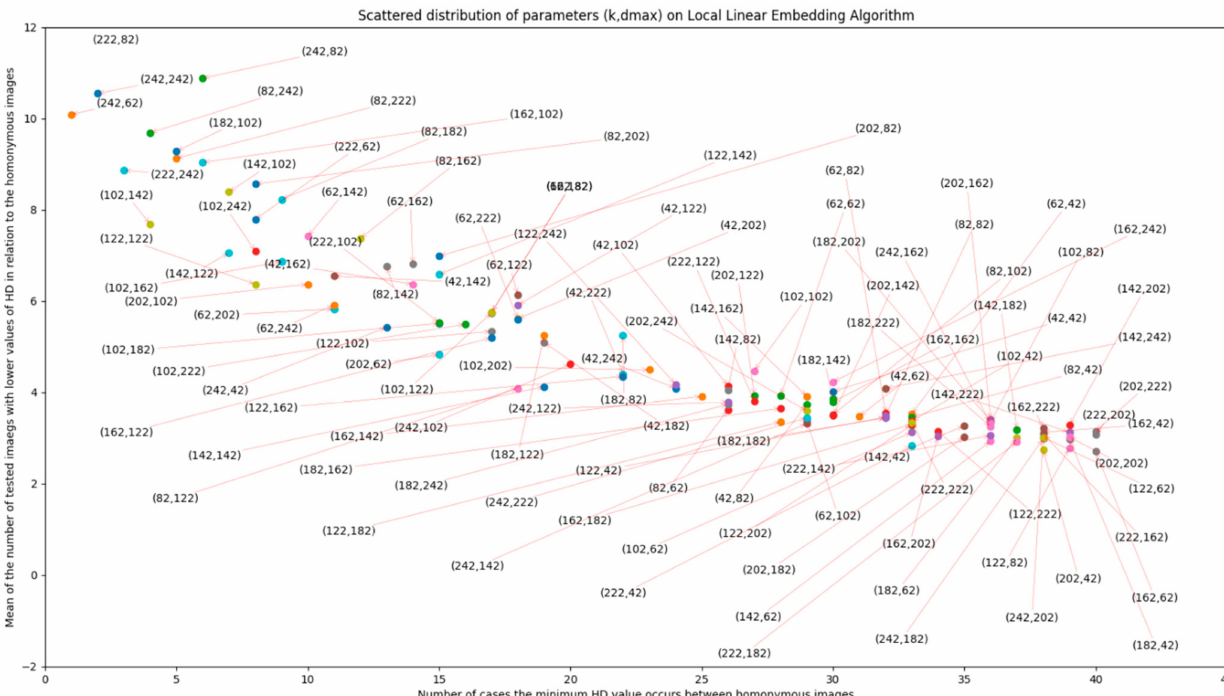
Figure A2. Number of correct matches (per 60 possible pairs) depending on the LLE parameter variation and the number of tested images with lower values of HD in relation to homonymous images.